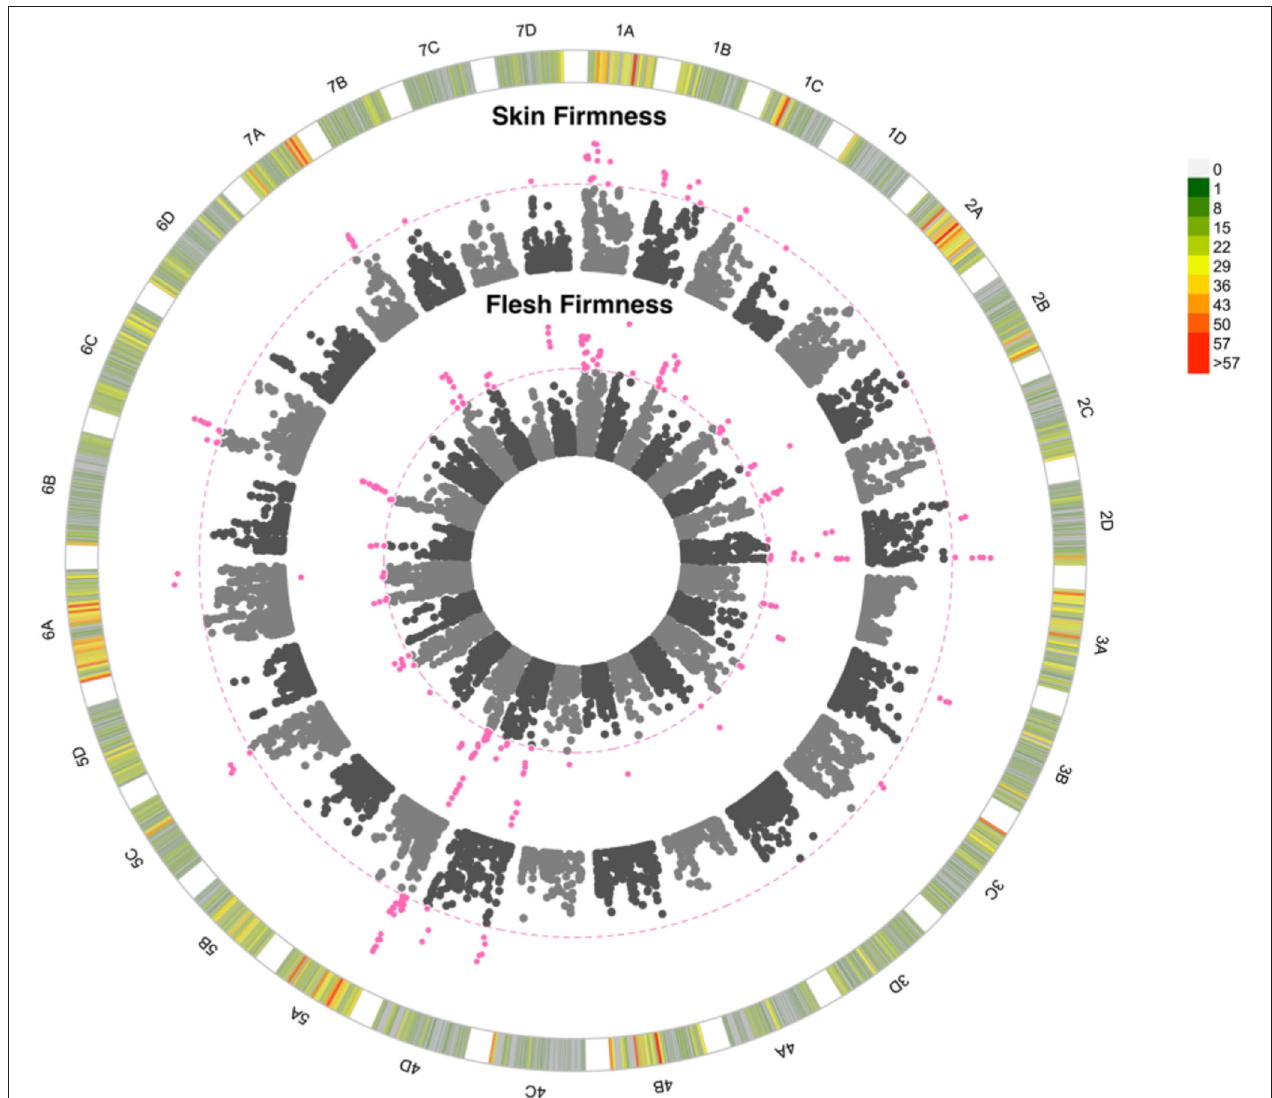
FIGURE 6 | Manhattan plot of GWAS looking at the association between SNPs and strawberry fruit firmness. 1A to 7D represent the 28 chromosomes of the strawberry genome. The inner Manhattan plot represents flesh firmness, the outer plot represents skin firmness. The pink dotted line represents Bonferroni correction at –log10 p = 7.14, pink points are those which pass the significance threshold. Marker positions are scaled to the Fragaria vesca genome v.4 (Li et al., 2019). The colour-coded key in the outermost circle represents the number of SNPs segregating at each point across the